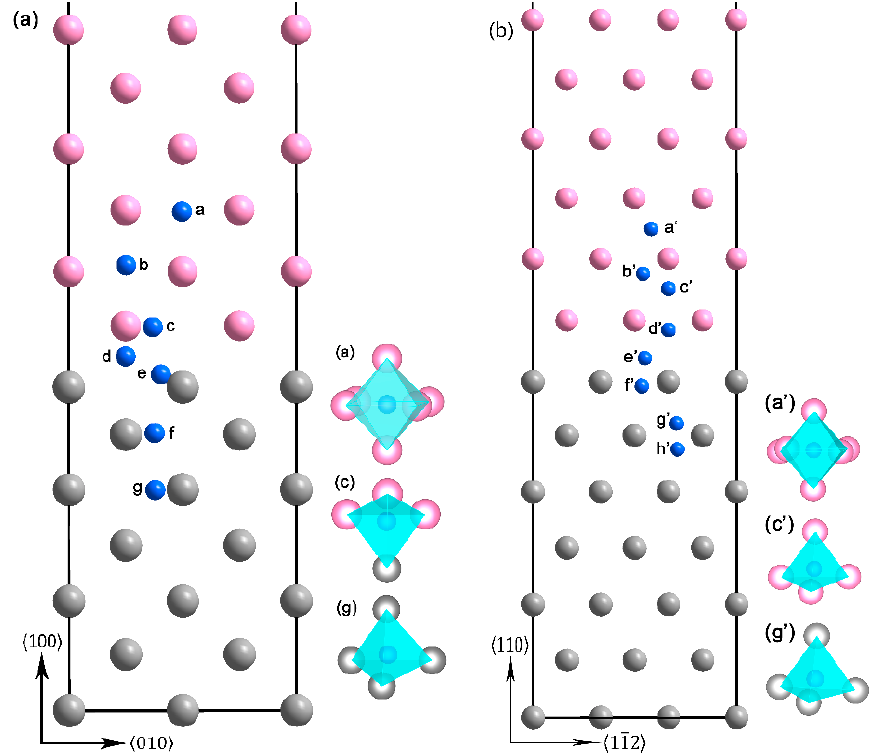
Figure 1. The geometric structures of ( a ) Li(100) / Ta(100) and ( b ) Li(110) / Ta(110) bilayers. The pink, gray, and blue atoms represent the Li, Ta, and H atoms (the H atoms here are used for the later calculation of the solution energy), respectively. The a-site and b-site in ( a ), and the a’-site in ( b ) are octahedral interstitial site (OIS), the rest sites are tetrahedral interstitial site (TIS). To determine the initial interface distance (d 0 ) of the bilayer models, W sep as a function of d 0 , was calculated and plotted in Figure 2. The optimal d 0 for the Li(100) / Ta(100) and Li(110) / Ta(110) bilayers are 1.612 Å, and 2.214 Å, respectively. The positive W sep values mean that both interfaces are mechanically stable [28]. Meanwhile, the interface energy ( γ int ) was also calculated to evaluate the thermodynamic stability and nucleation resistance of both interfaces. The γ int values for the Li(100) / Ta(100) and Li(110) / Ta(110) interfaces are 1.606, and 1.245 eV, respectively. Positive γ int values mean that both interfaces are thermodynamically stable [28]. Therefore, both Li(100) / Ta(100) and Li(110) / Ta(110) interfaces are mechanically and thermodynamically